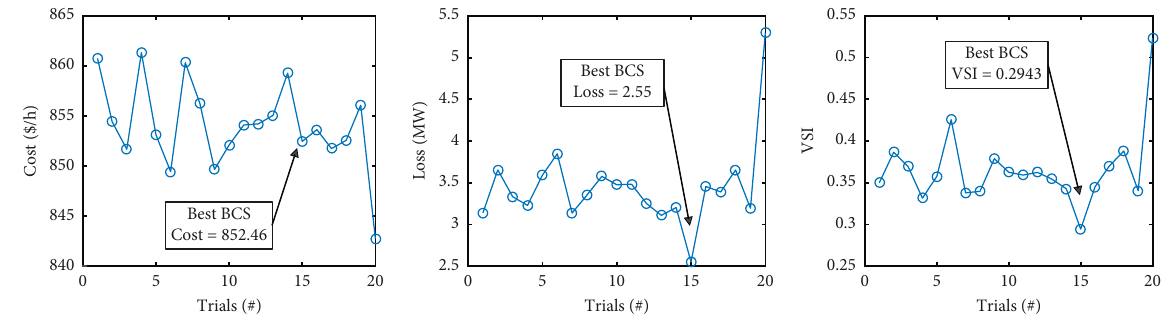
Figure 6: 20 independent trials run for case 1